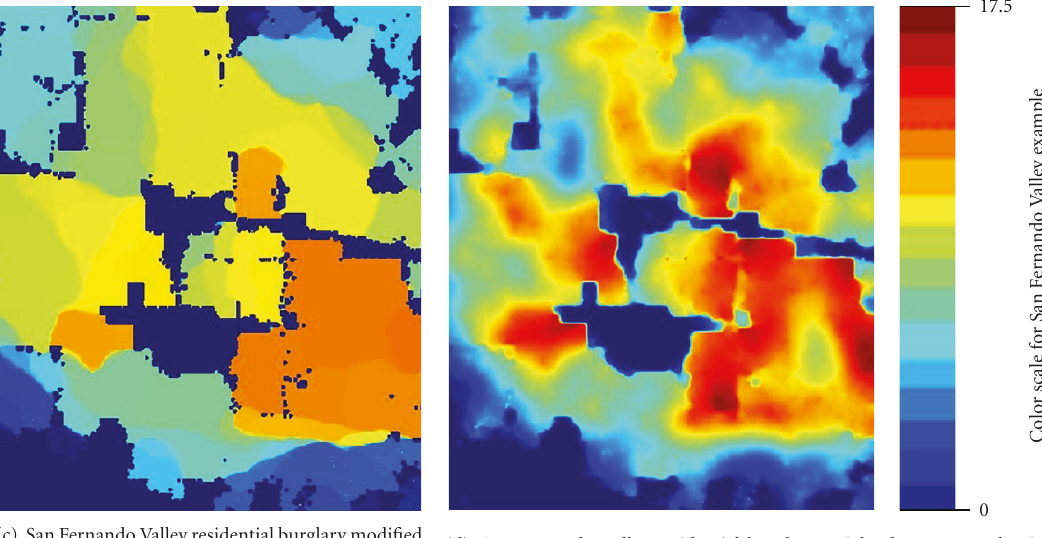
Figure 11: These images are the density estimates for the San Fernando Valley residential burglary data. (a) and (b) show the results of the current methods Kernel Density Estimation and TV MPLE, respectively. The results from our Modified TV MPLE method and our Weighted H 1 MPLE method are shown in figures (c) and (d), respectively. The color scale represents the number of residential burglaries per year per square